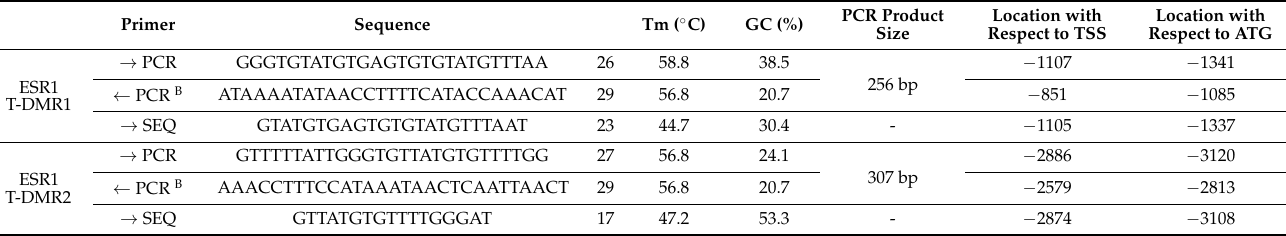
Table 1. Primer sequences and location.